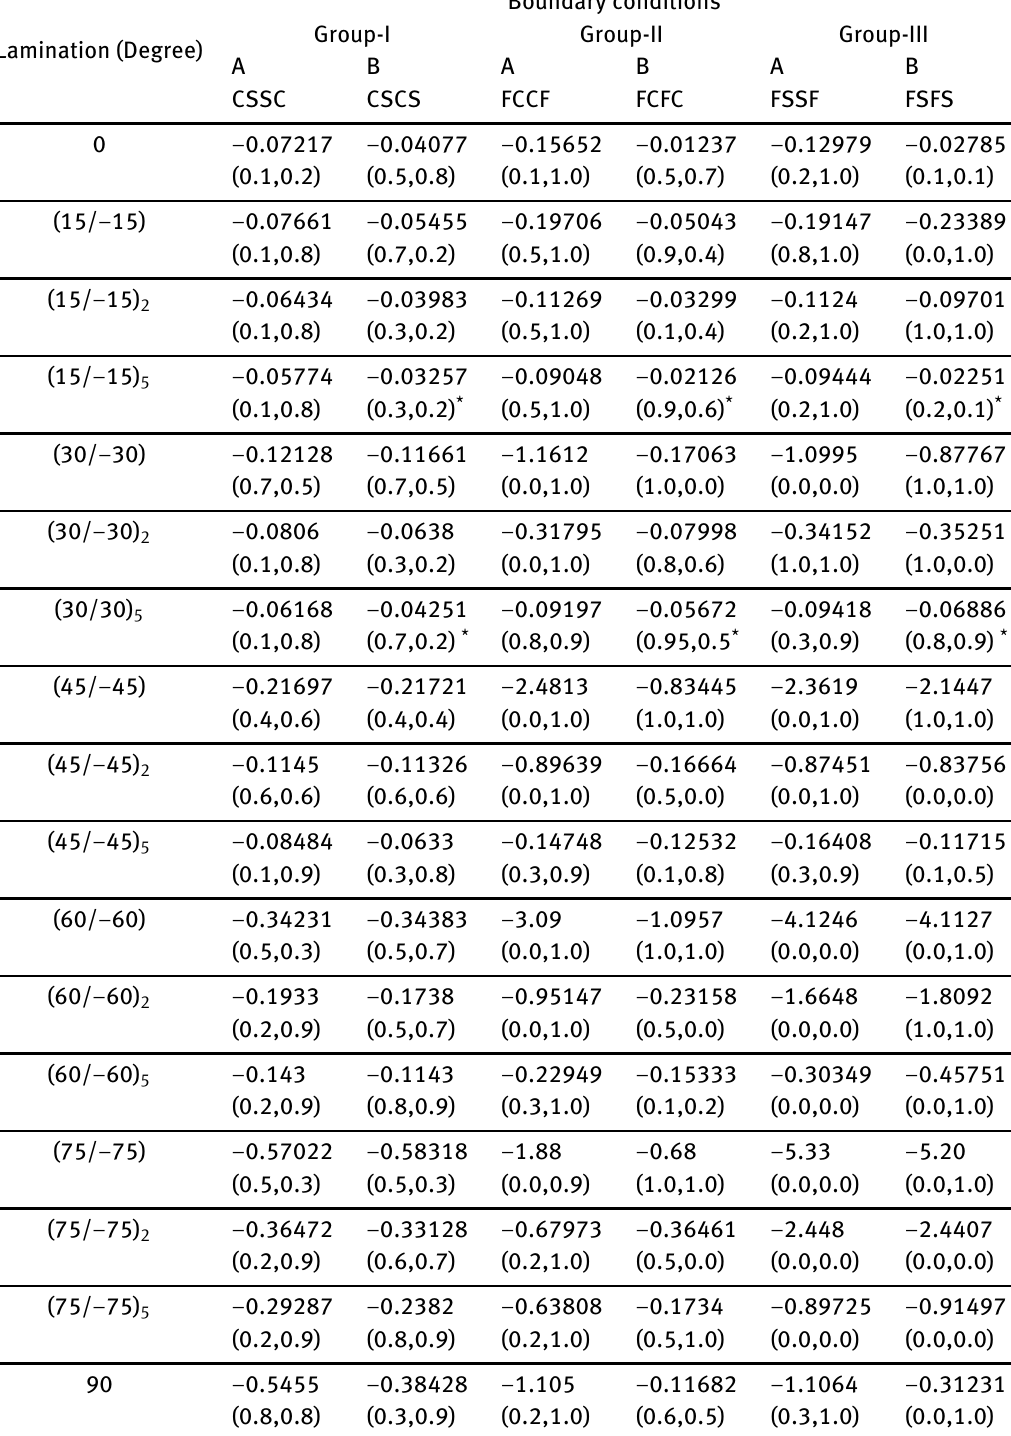
Table 11: Values of maximum non-dimensional sagging moments (− M x ) x 10 2 for different antisymmetric angle ply lamination and boundary conditions of stiffened composite hypar shell with